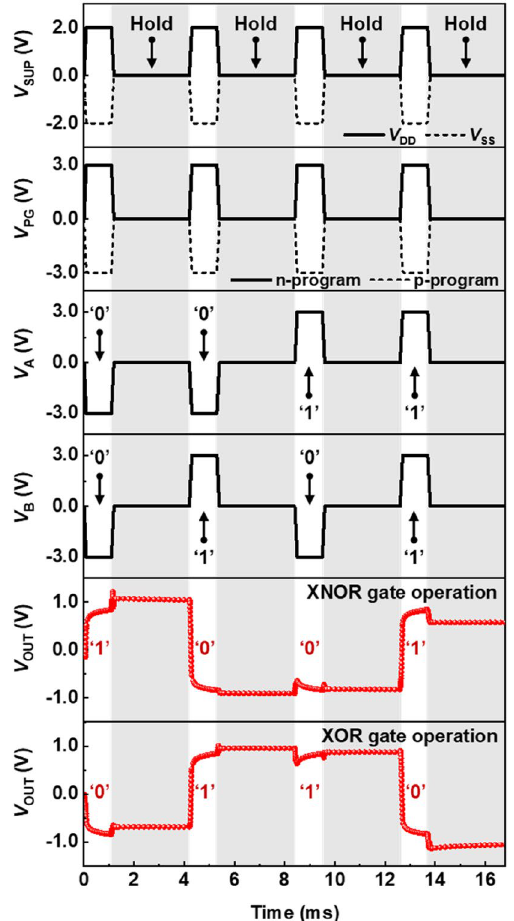
Figure 4. Logic-in-memory (LIM) operation of the ULIM cell. Timing diagrams when applying repeated pulses for XNOR and XOR logic gate